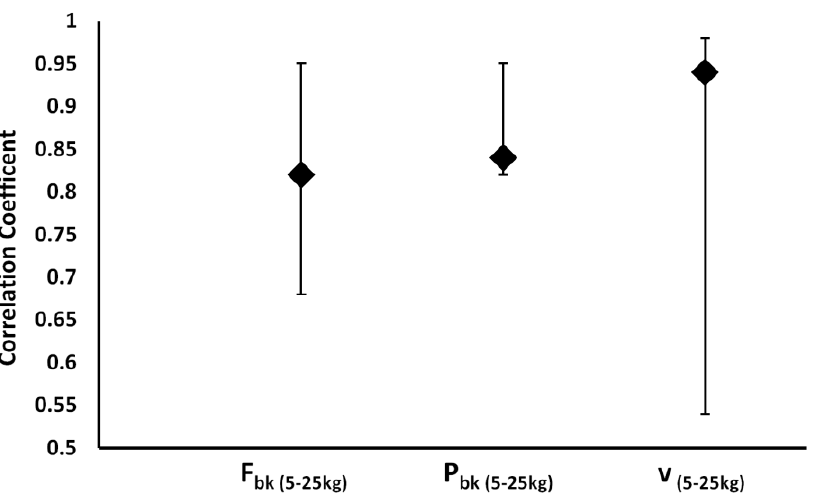
Figure 2. Median correlation coefficients and their ranges obtained comparing the vertical thrust’s height free load with individual F bk , P bk and v at 5–25 kg.